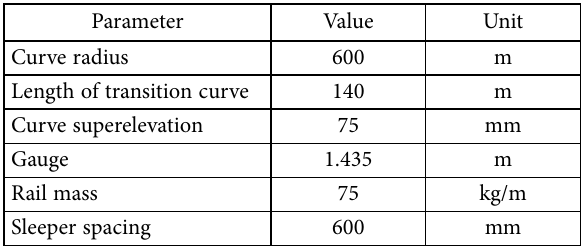
Table 1. Main parameters of the ballast